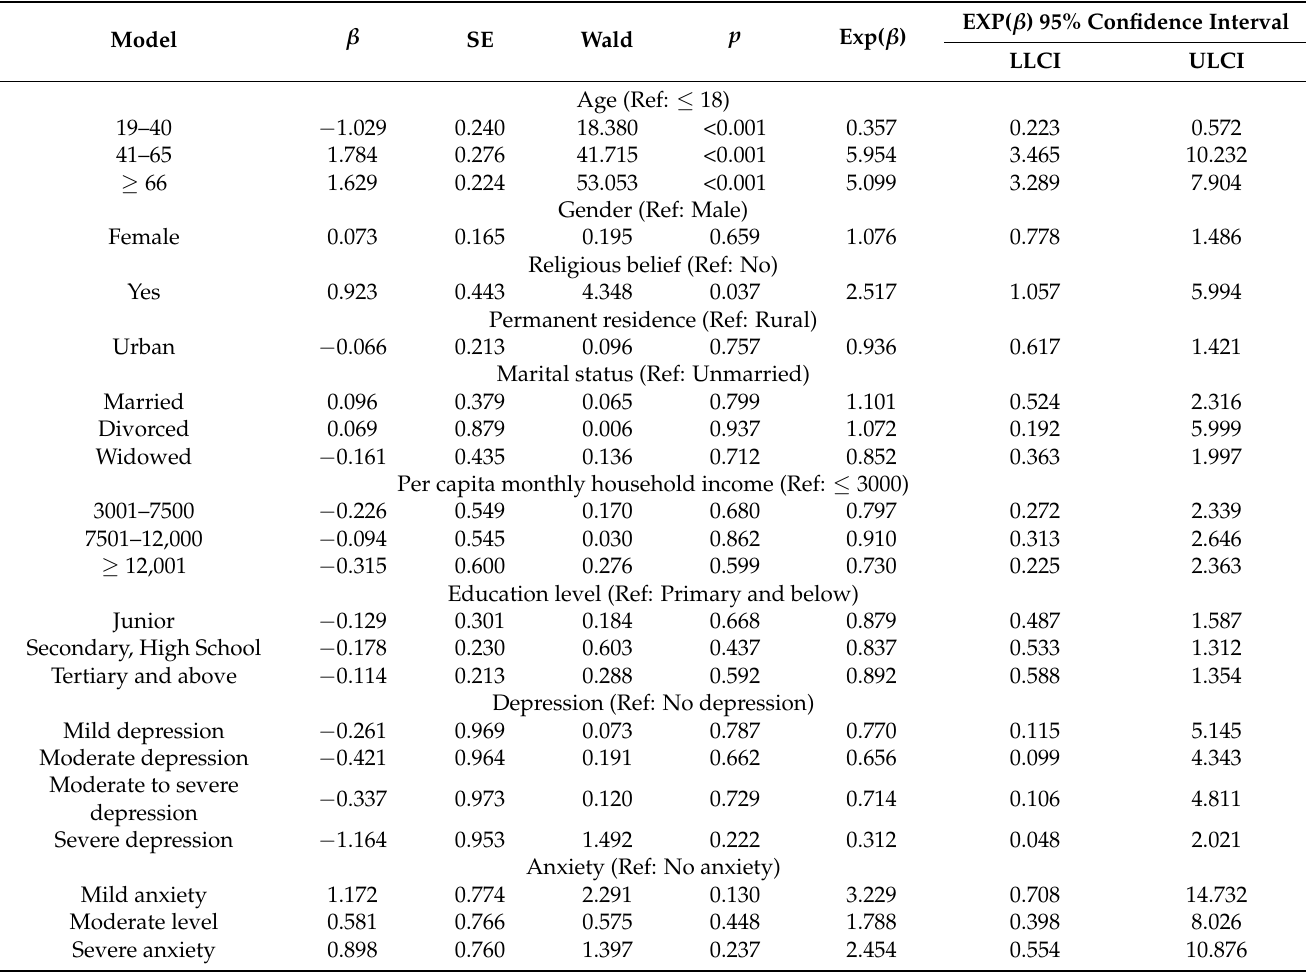
Table 5. Binary logistic regression analysis of COVID-19 vaccination in the media use low frequency.